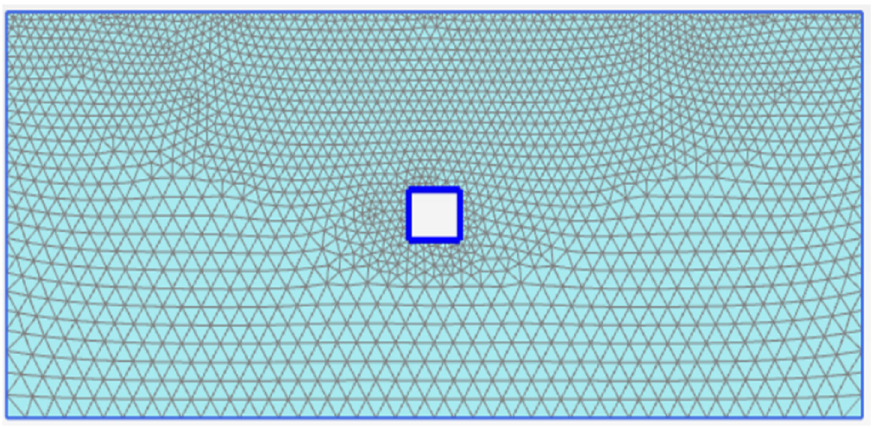
Figure 4. Geometry of the FEM model.